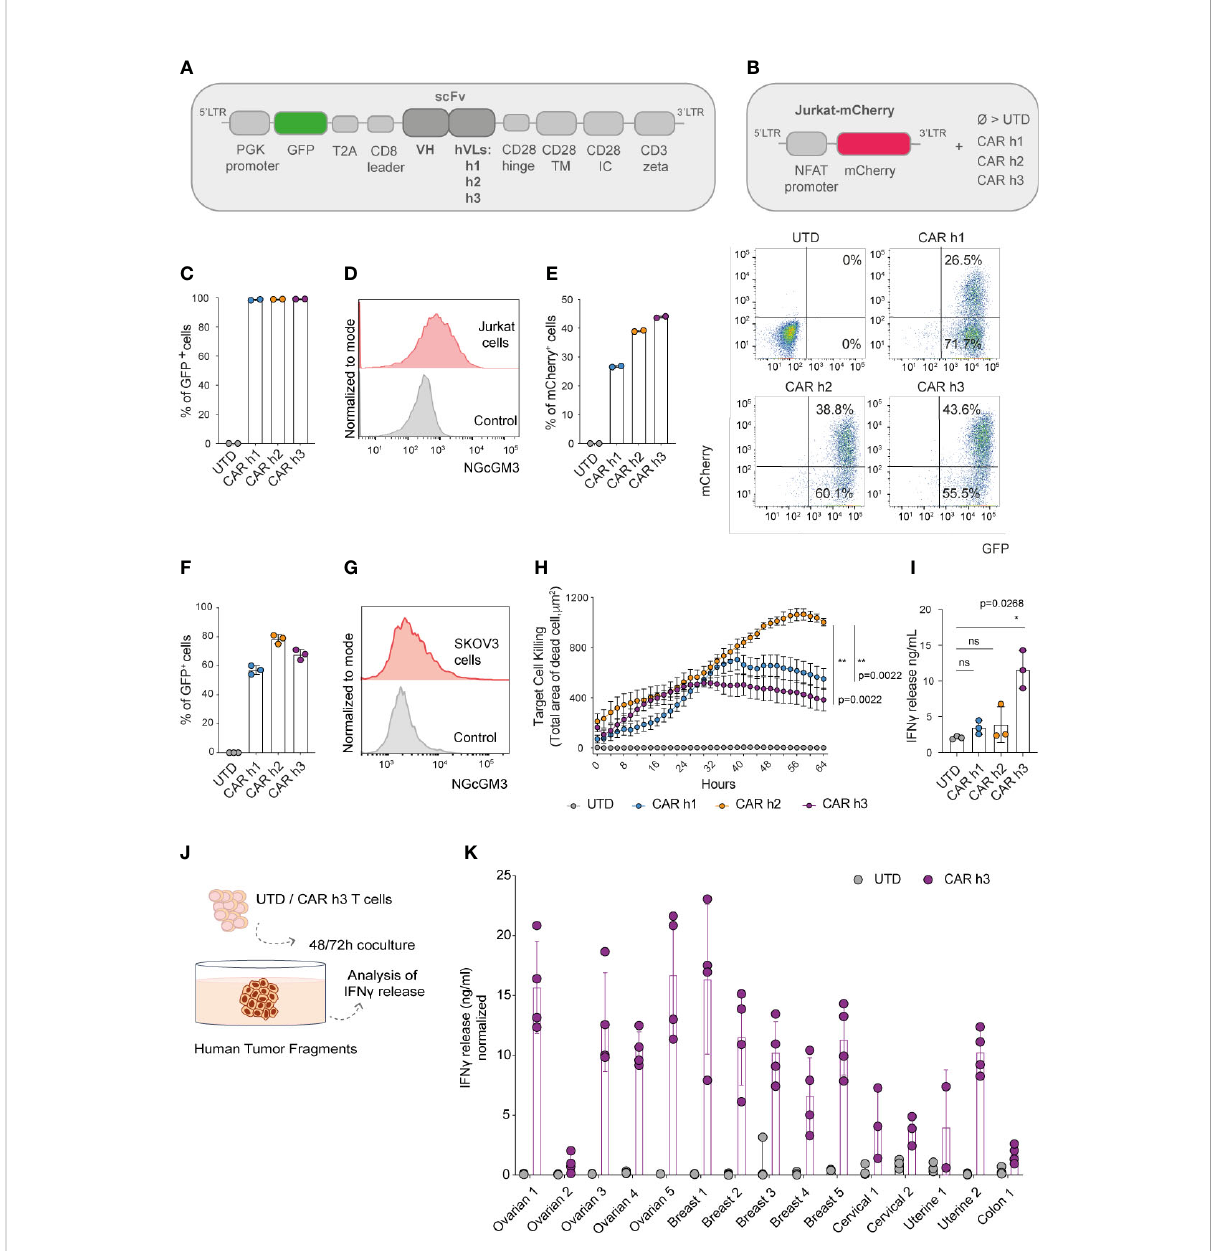
FIGURE 1 Anti-NGcGM3 CAR T cells demonstrate reactivity in vitro against NGcGM3 + SKOV3 ovarian tumor cells and a panel of patient biopsies. (A) Schematic of lentiviral vectors encoding GFP and the different 14F7-based anti-NGcGM3 CARs. (B) Schematic of the vector used to generate Jurkat-mCherry reporter cells which were then transduced with the 3 CAR variants (CAR h1, h2 and h3) or not (UTD=untransduced) (C) Evaluation of CAR expression by transduced Jurkat-mCherry reporter cells as assessed by GFP expression measured by fl ow cytometric analysis. (D) NGcGM3 expression on Jurkat cell surfaces as assessed by fl ow cytometric analysis (top, in red) and secondary antibody staining alone control (bottom, in grey). (E) mCherry expression levels in transduced Jurkat-mCherry reporter cells at 48h (left) and representative dot plots of reporter gene and CAR expression (evaluated by GFP expression) (right). (F) Percent GFP expression by lentivirally transduced primary human T cells assessed by fl ow cytometry. (G) SKOV3 cell line NGcGM3 expression (in red) assessed by fl owcytometry compared to control (secondary Ab alone, in grey). (H) Anti-NGcGM3 CAR T cell killing of SKOV3 tumor cells (calculated as dead cell count/µm 2 ) measured over days in an IncuCyte assay. (I) IFN g production by anti-NGcGM3 CAR T cells upon 24h coculture with SKOV3 tumor cells. (J) Schematic of anti-NGcGM3 CAR untransduced (UTD) T cell coculture with patient tumor fragments. (K) IFN g release in anti-NGcGM3 CAR T cell and tumor fragment coculture assays. Shown is average ± standard deviation (SD) (F, I, K) or standard error mean (sem) (H) of different cultures. Statistical analysis by unpaired, two-tailed Mann-Whitney test (H) and paired, two-tailed t test (I) . (**p< 0.01; *p < 0.05; ns, non-signi fi cant). All experiments were performed for a minimum of n=3